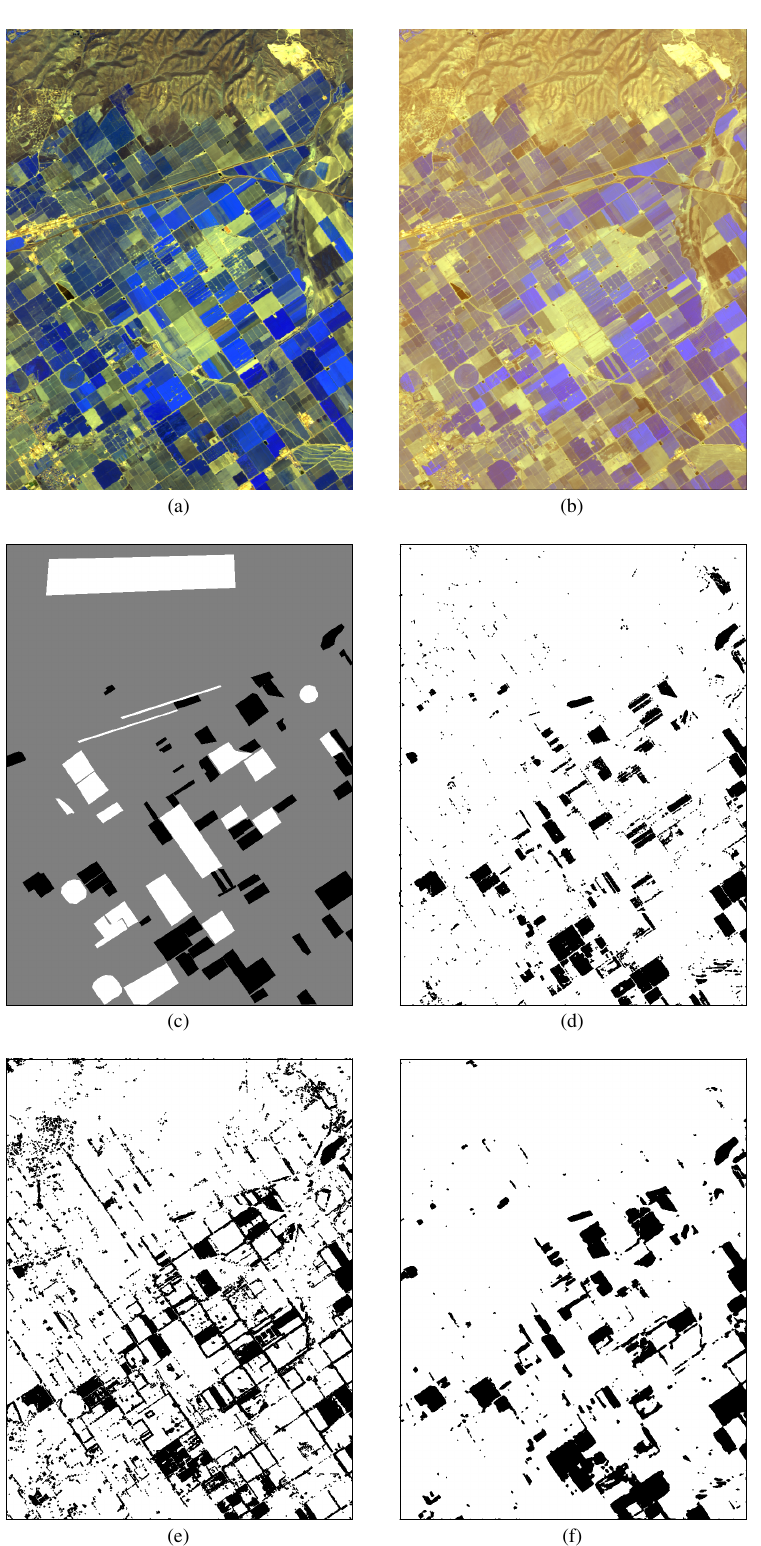
Figure 3. Visualization of the Santa Barbara scene: (a) pre-change image, (b) post-change image, (c) reference image ( black pixels are changed, white pixels are unchanged, and gray pixels are unknown), and CD maps: (d) CVA, (e) DCVA, (f) Proposed approach, i.e., fusion of the untrained